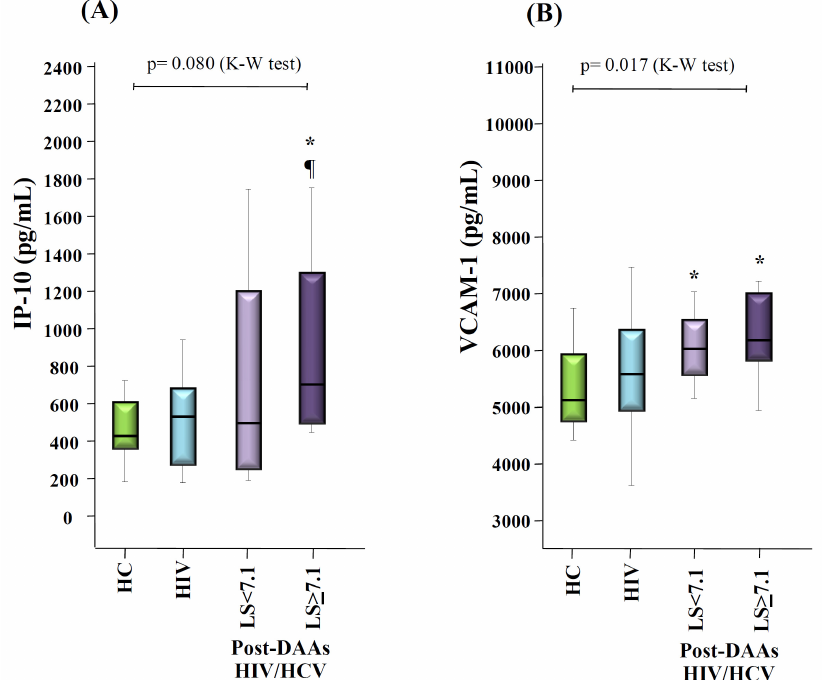
Figure 4. Box-plots graphs showing the levels of IP-10 ( A ), and VCAM-1 ( B ), in HC donors (HC), HIV monoinfected (HIV), and HIV/HCV coinfected patients at 12 weeks after the end of DAAs therapy (post-DAAs HIV/HCV), stratified according to the level of liver stiffness (LS) at baseline (before DAAs treatment). p -values for the global comparison between the groups (Kruskal-Wallis test; K-W) are shown. (*): p < 0.05 with respect to HC donors (Mann-Whitney U test). (¶): p < 0.05 with respect to the HIV group (Mann-Whitney U test).